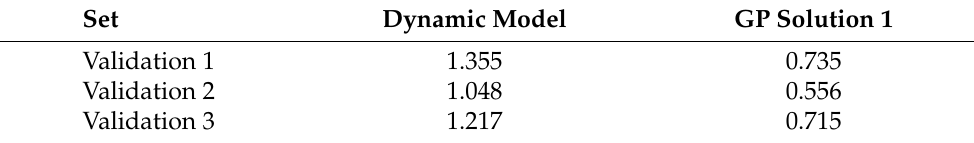
Figure 14. Position error bar for ( a ) first validation input command set, ( b ) second validation input command set, and ( c ) third validation input command set. Table 2. Root mean square error of GP and dynamic